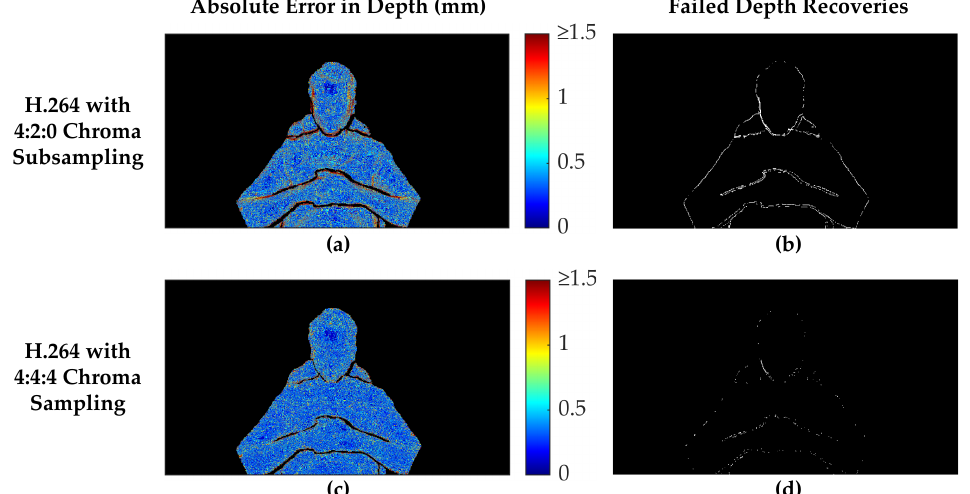
Figure 7. Comparison of depth reconstruction results between 4:2:0 chroma subsampling and 4:4:4 chroma sampling for an example frame. The H.264 codec was used with an average video bitrate of 15 Mbps in each case. The absolute error of the depth maps are shown in the left column, with filtered depth values shown as black. The right column shows white pixels where depth measurements that were present in the original ground truth data failed to be recovered in the final decoded and postprocessed depth map. The MWD encoding used n stairs = 6 and other settings were as described in the first paragraph of Section 3.2. The selected frame has a Recall of 0.9940 when using 4:4:4 chroma sampling, but only 0.9699 with 4:2:0 chroma subsampling. The recovered region in ( a ) has an RMSE of 1.030 mm and MAE of 0.5247, while ( c ) using 4:4:4 chroma sampling has a substantially